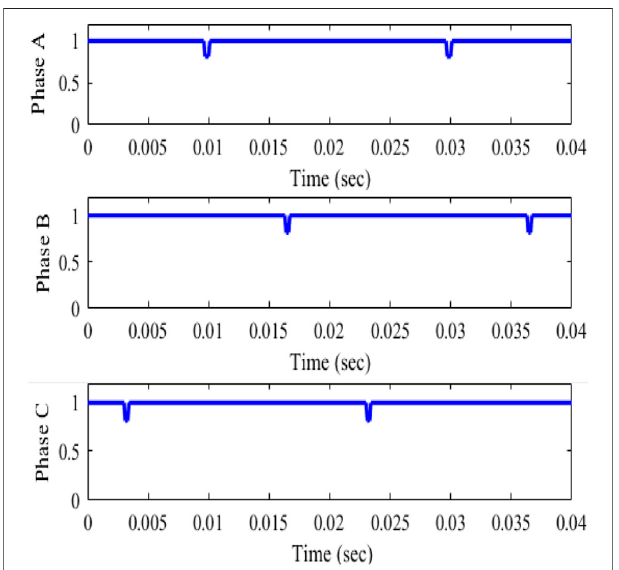
FIGURE 17 | Total harmonic distortion without the fi lter.